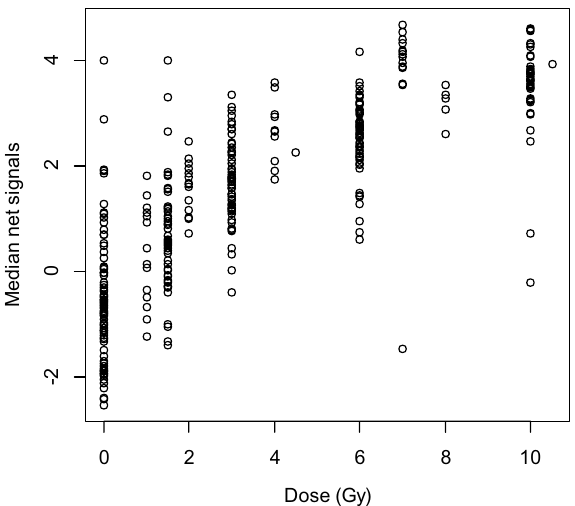
Figure 2. Normalized N (Net Signal) versus Dose (Gy) plots for all 30 genes included in the microarray signature. Net signal (N) is the difference between the median of the DCt of up regulated genes and down regulated genes. This value is a better indicator of dose response than either group alone, or any one gene alone, and was used for developing the model.